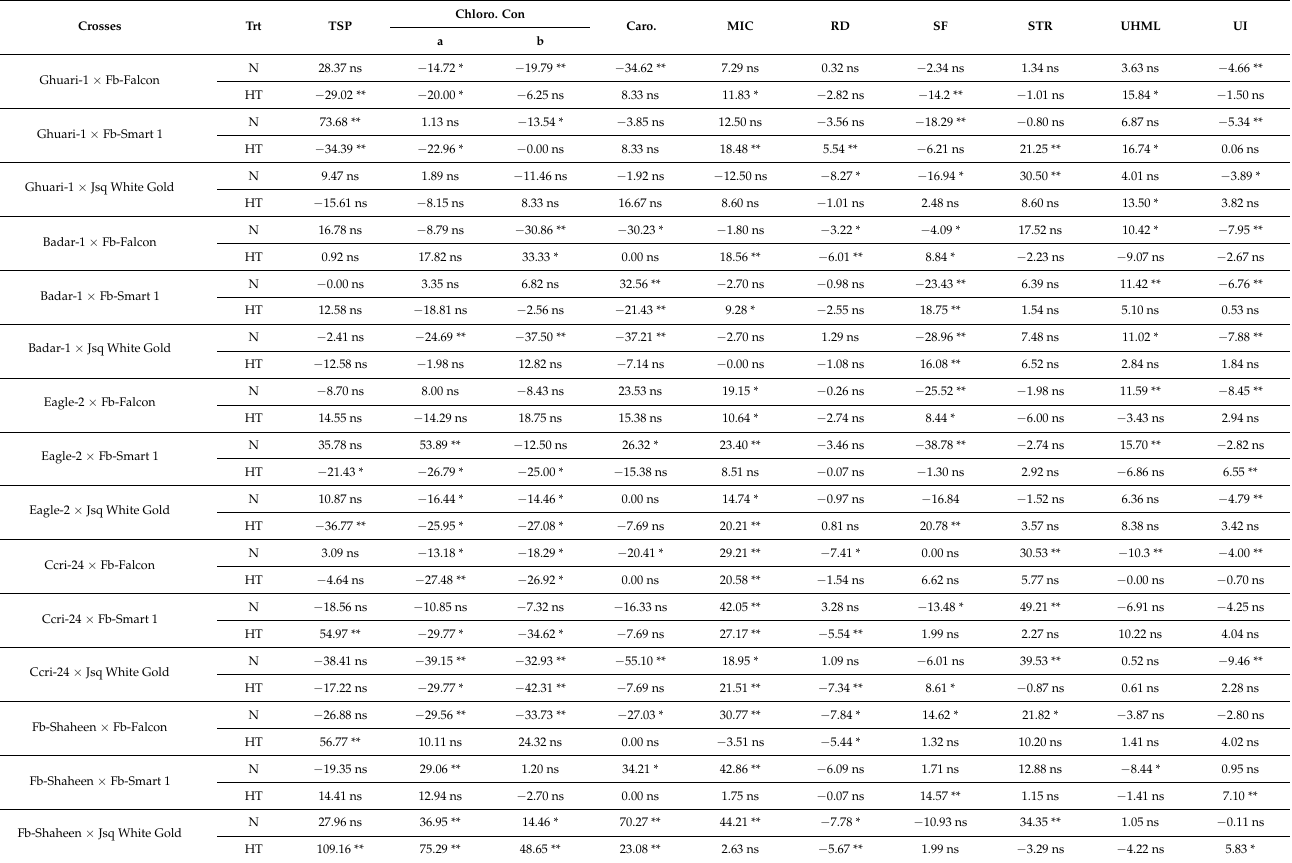
Table 13. Second year heterosis effects of various traits under normal and high temperature stress